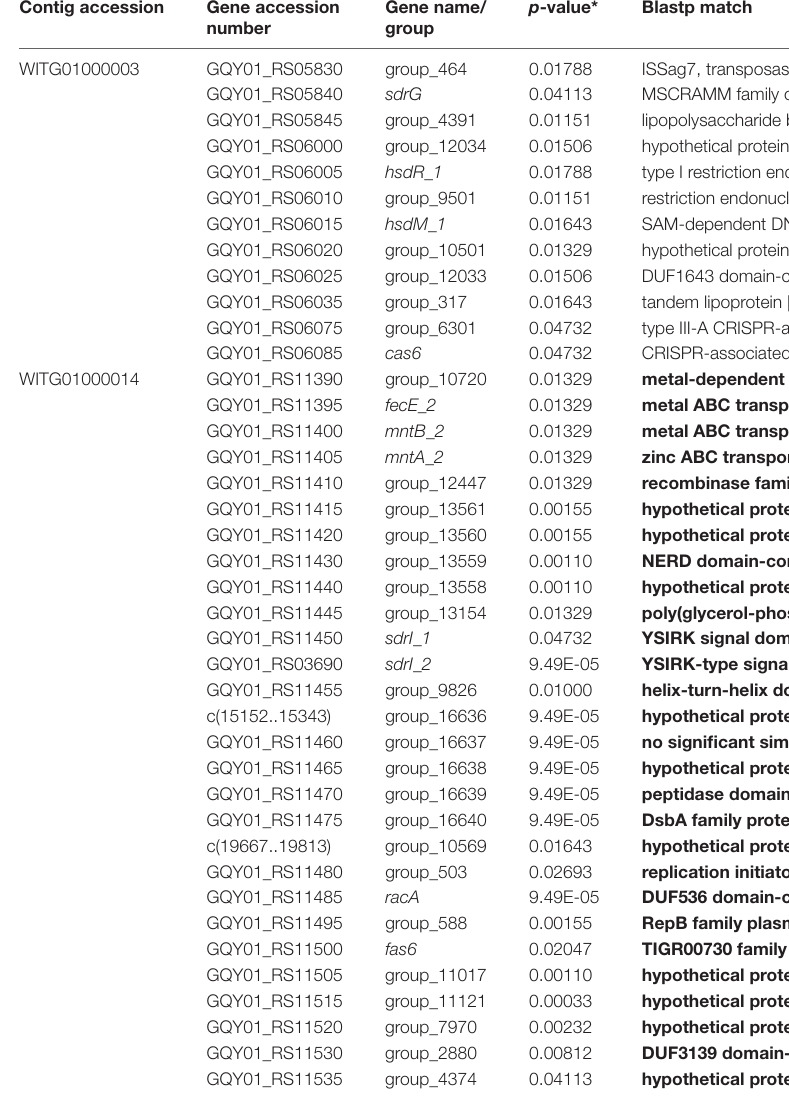
TABLE 1 | Genes significantly correlated with gut-associated S. epidermidis isolates. Contig